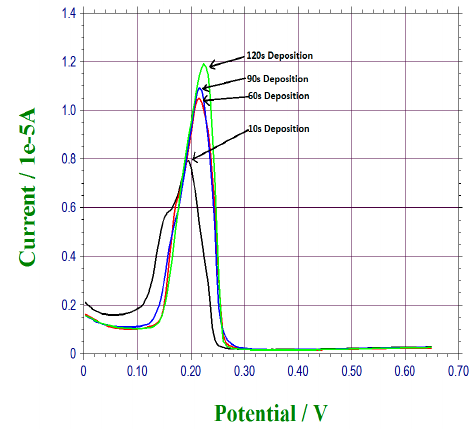
Figure 5. Electrochemical stripping analysis of lead ions for different deposition time ranging from 10 s to 120 s.